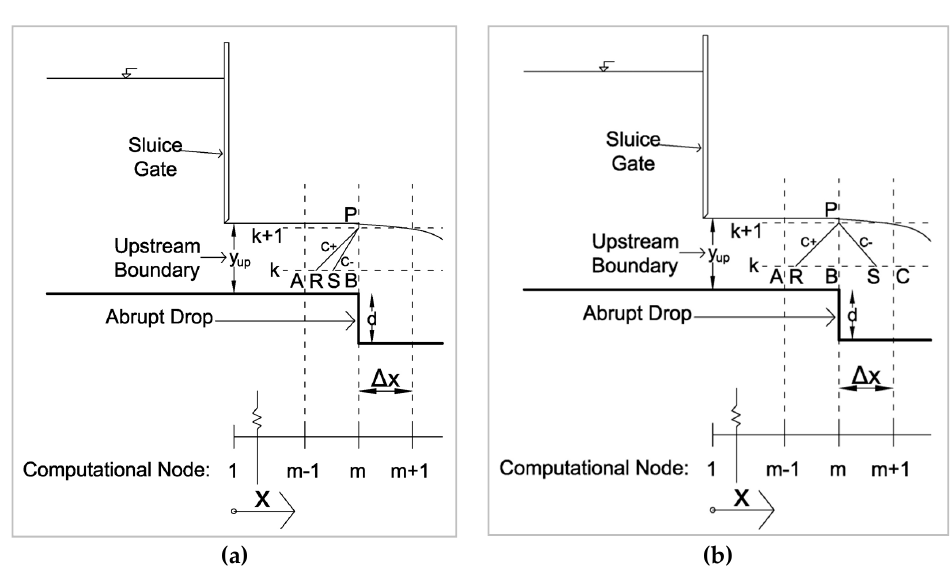
Figure A2. Characteristic curves at the drop: ( a ) Supercritical flow; ( b ) Subcritical flow. In the case of the A-jump the flow is subcritical at the step. The difference in comparison with the minimum B-jump is the direction of the negative characteristic curve shown in Figure A2b. In Figure A2b, points A, B and C correspond to nodes m − 1, m and m + 1 respectively at time level k, while the positive and the negative characteristics passing through point P with unknown flow depth and velocity at node m at the time level k + 1 are indicated. The point R is the intersection of the positive characteristic passing through point P with the grid line of time level k. The velocity, the celerity the flow depth as well as the energy line slope at point R are calculated from Equations (A9)–(A12) with u A = u k u B = u k . Point S is the intersection of the negative characteristic passing through point P m with the grid line of time level k. The velocity, the celerity, the flow depth as well as the energy line slope at point S through the negative characteristic curve are computed [32] from Equations (A20)–(A23)